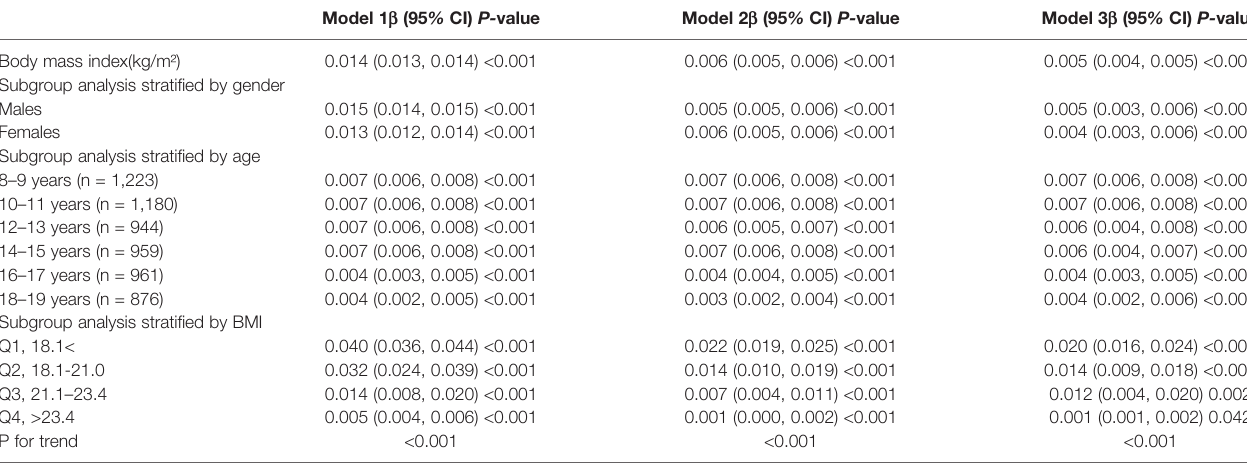
TABLE 2 | Association between BMI (kg/m²) and total bone mineral density (g/cm 2 ).